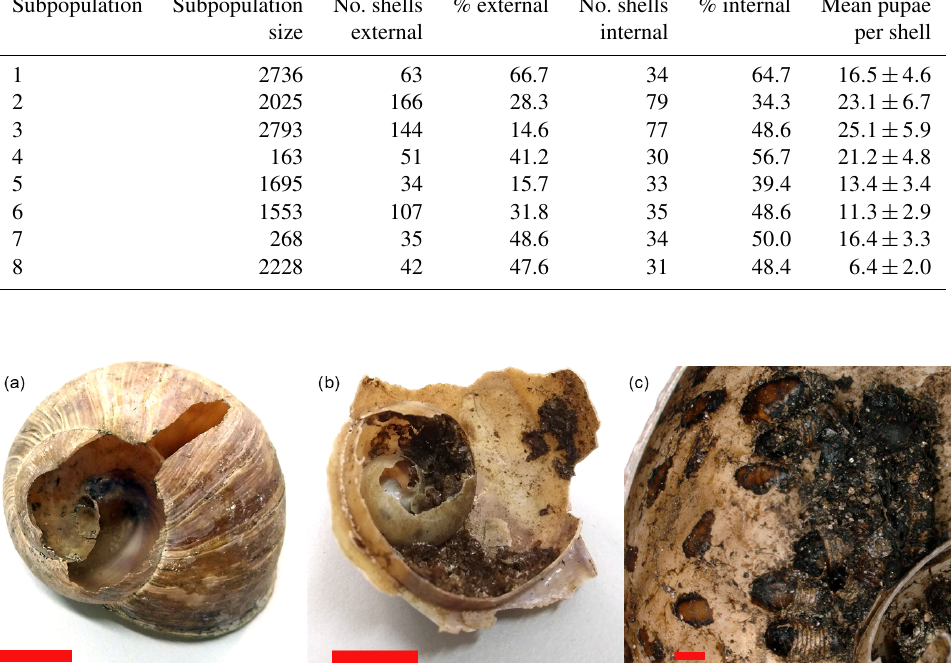
Figure 1. Helix pomatia shells with (a) external attack marks (bird attack), (b) internal utilization marks from Diptera pupae and (c) details of internal utilization marks with Diptera pupae. The scale bar shows 1cm in (a) and (b) and 1mm in (c) .